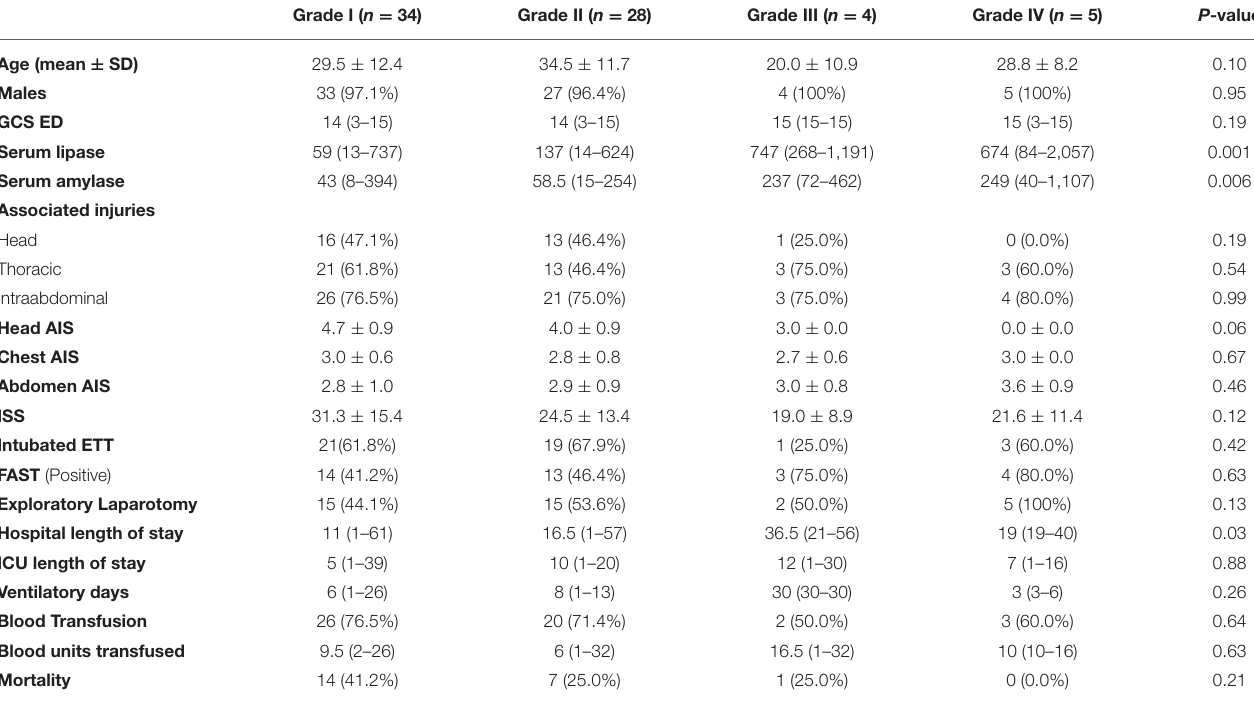
TABLE 2 | Demographics, clinical presentation and associated injuries by pancreatic injury